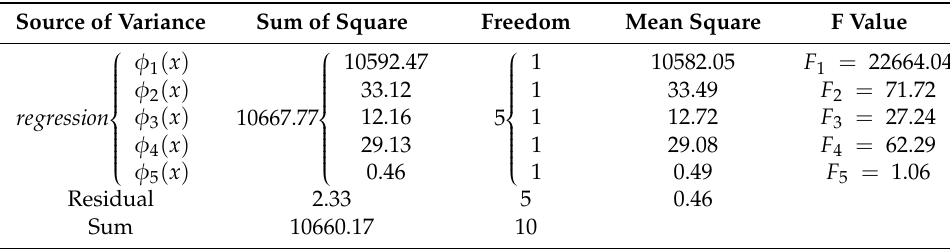
Table 7. Analysis of variance of orthogonal